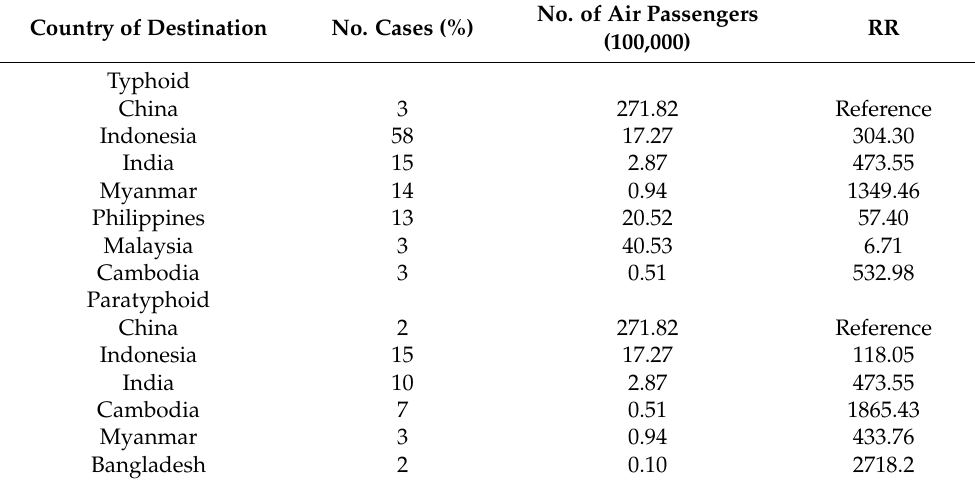
Table 4. Travel destinations of 109 imported cases of typhoid and 39 imported cases of paratyphoid in Taiwan between 2011 and 2020.